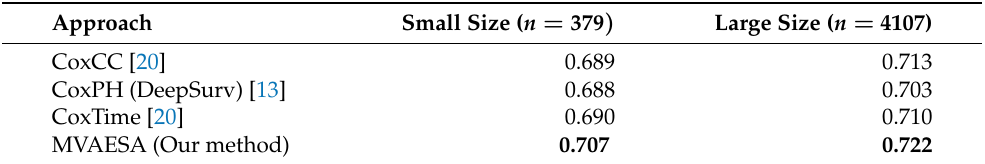
Table 3. Comparison of model performances (C-index) between methods for survival analysis with different training sizes from the independent validation set (test set) ( n = 1099). Approach